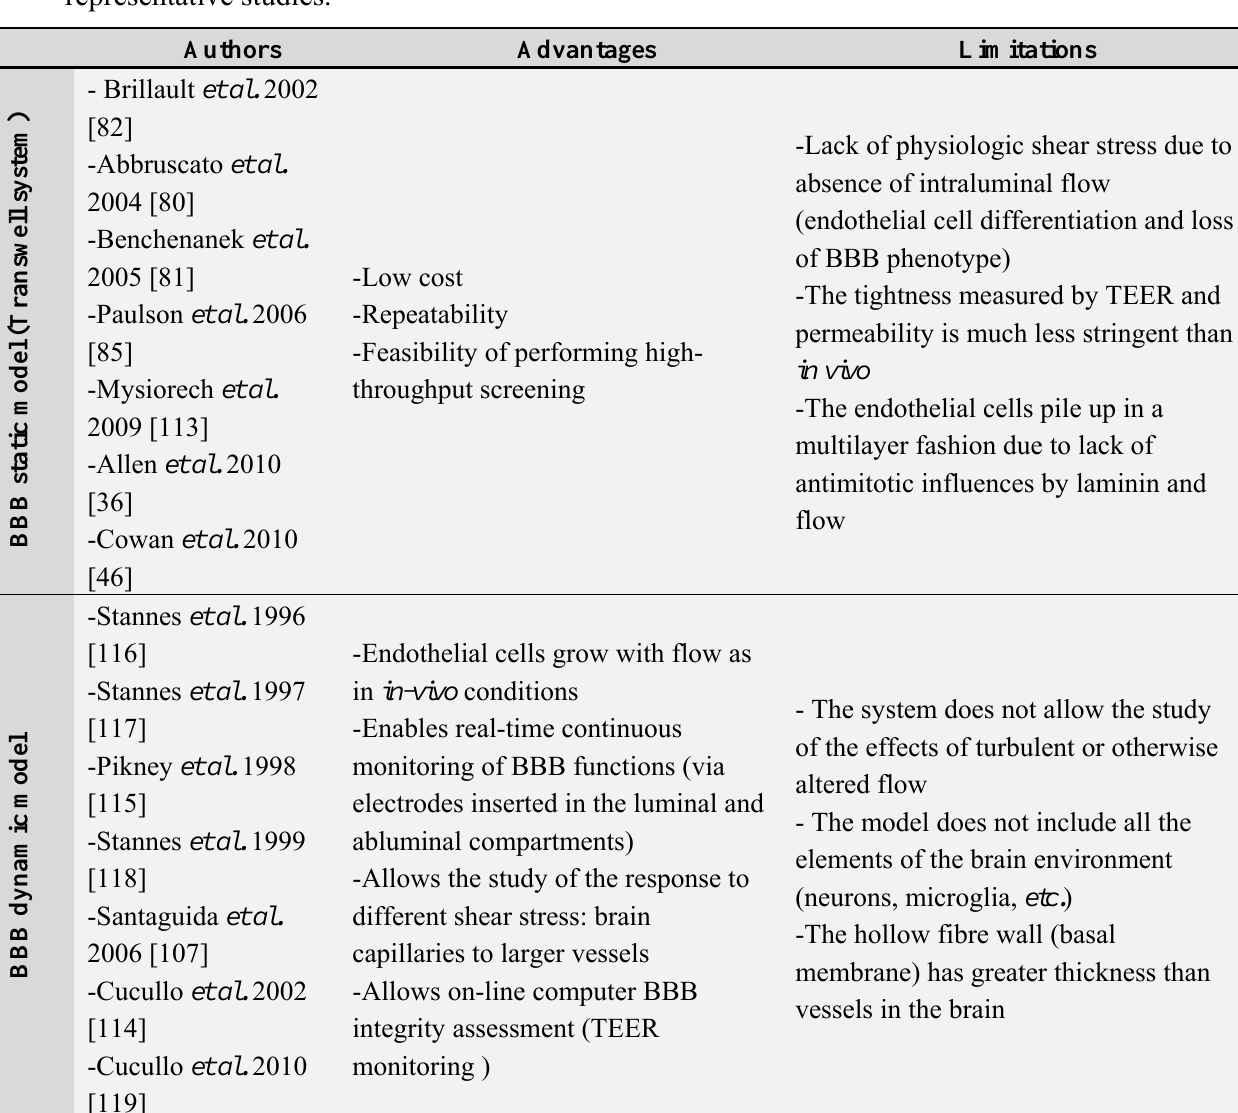
Table 4. Advantages and limitations of the different in-vitro BBB models and some representative